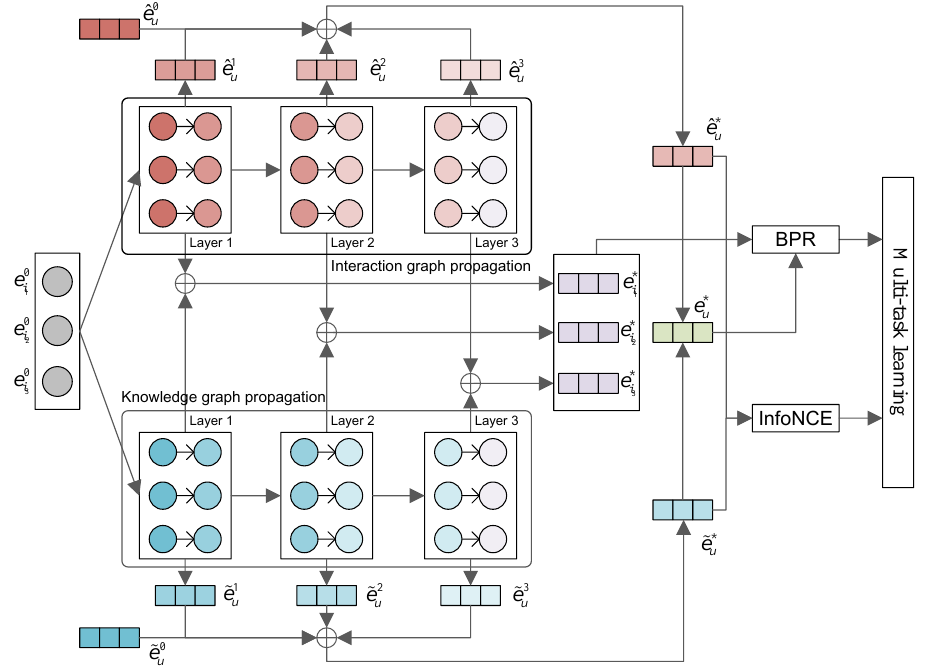
Figure 1. The framework of